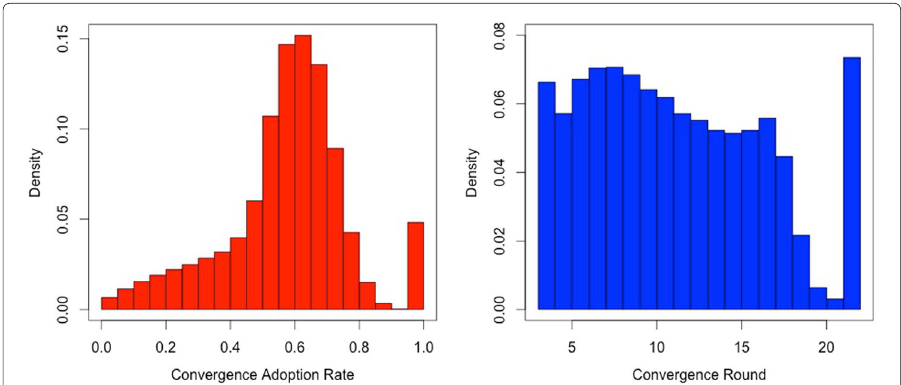
Fig. 6 Histograms of convergence adoption rates and convergence rounds (negative externality